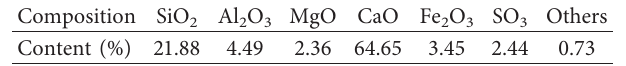
Table 1: Cement chemical